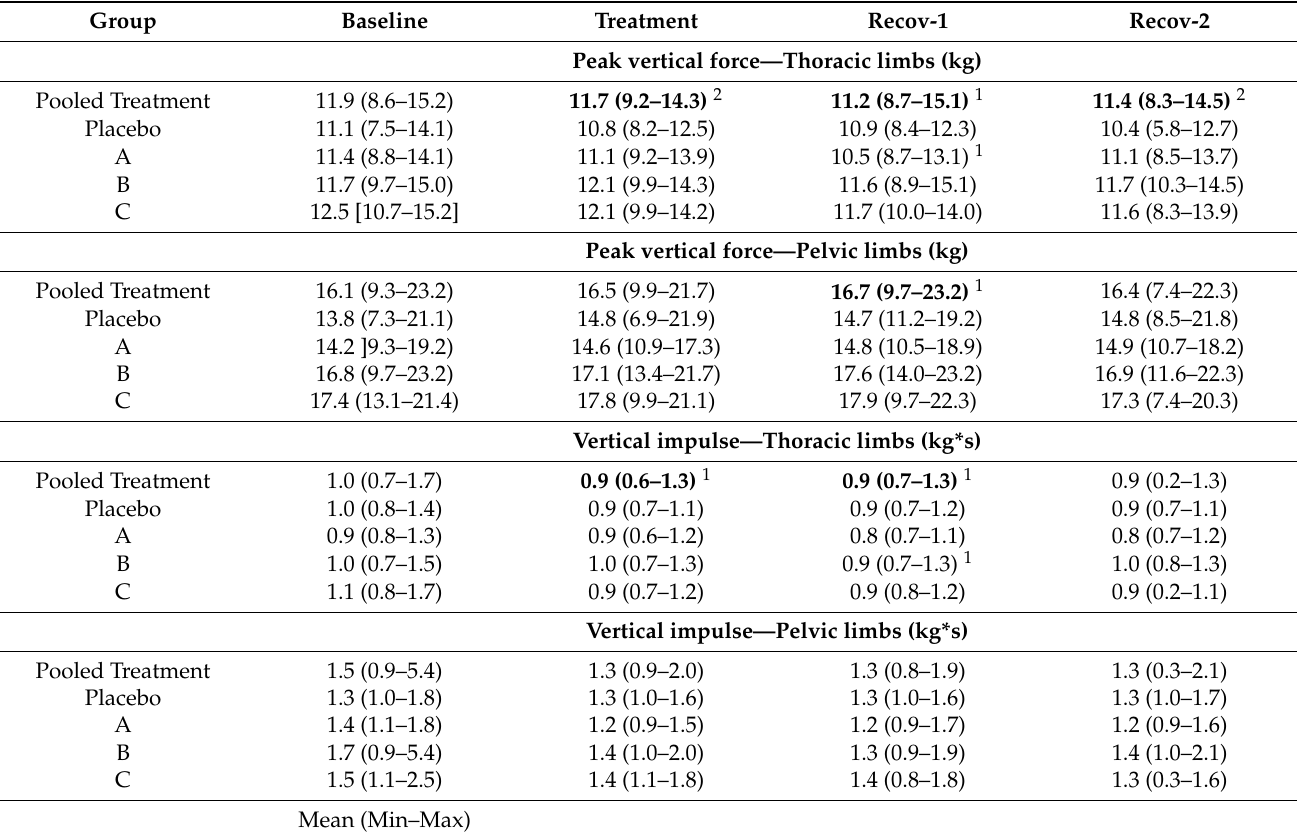
Figure 2. Cat velocity on the platform before jumping down. p ‐ values are adjusted using Bonferroni correction. Group A = 0.40 mg/kg, Group B = 0.25 mg/kg, Group C = 0.15 mg/kg of Firocoxib. Recov-1 and Recov-2 = first and second recovery periods. Table 3. Descriptive analysis of peak vertical force and vertical impulse raw data according to treatment